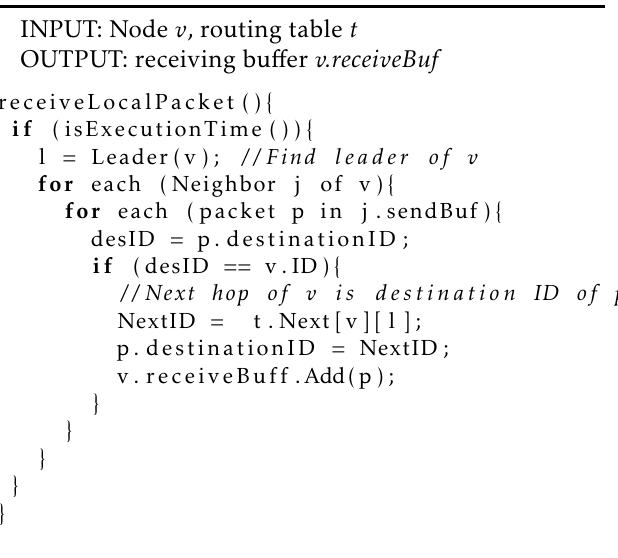
ALGORITHM : receive local packets at a